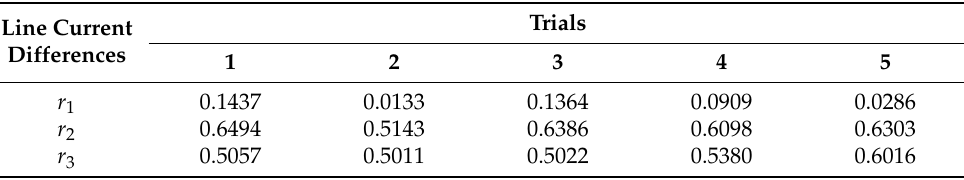
Table 5. Arithmetic differences of the line current RMS values from a motor with 12% of the coils in its phase I c winding short-circuited.